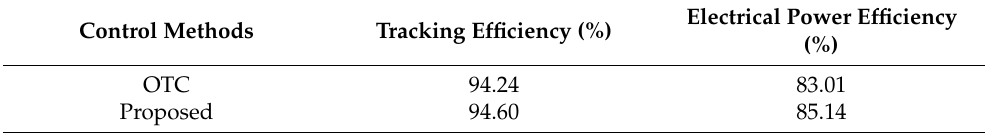
Figure 18. Experimental results for real wind speed: ( a ) Beta β . ( b ) Grid output power. Table 3. PMVG rotor speed tracking performance analysis and electrical power efficiency from the experimental